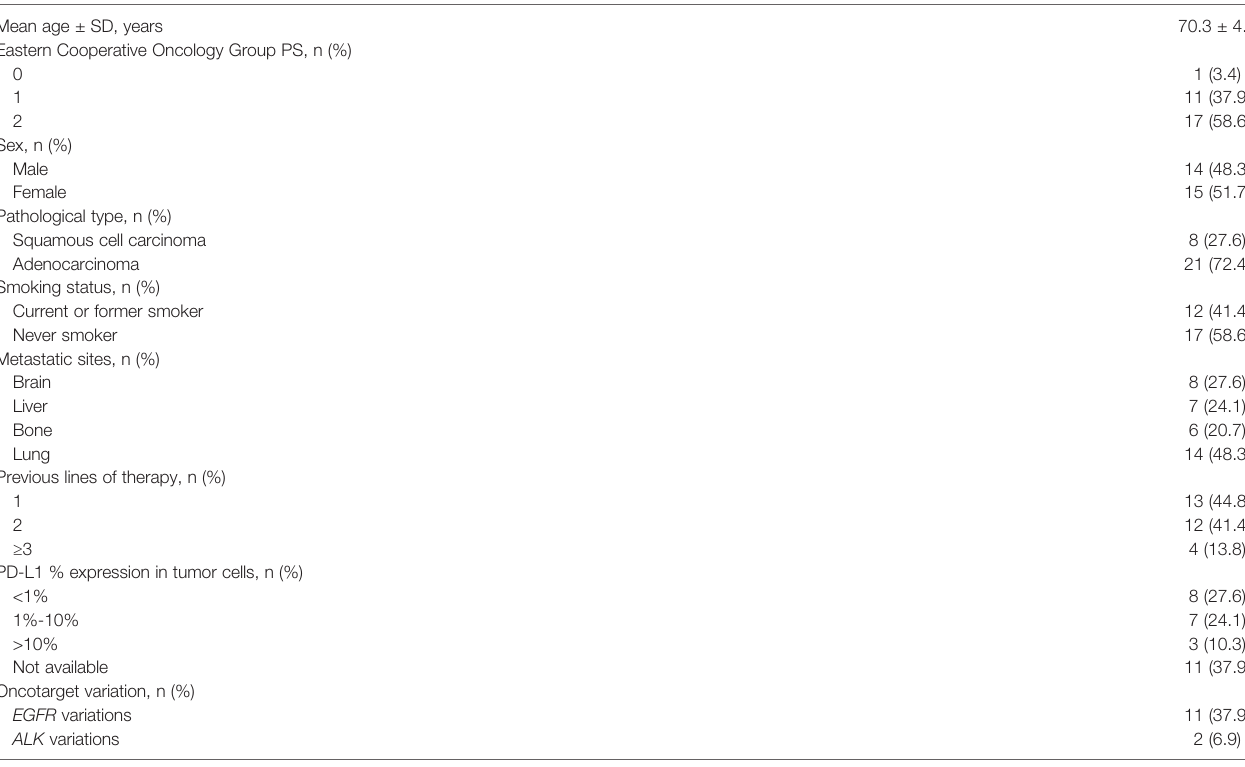
TABLE 1 | Demographic and baseline characteristics of study patients (N =